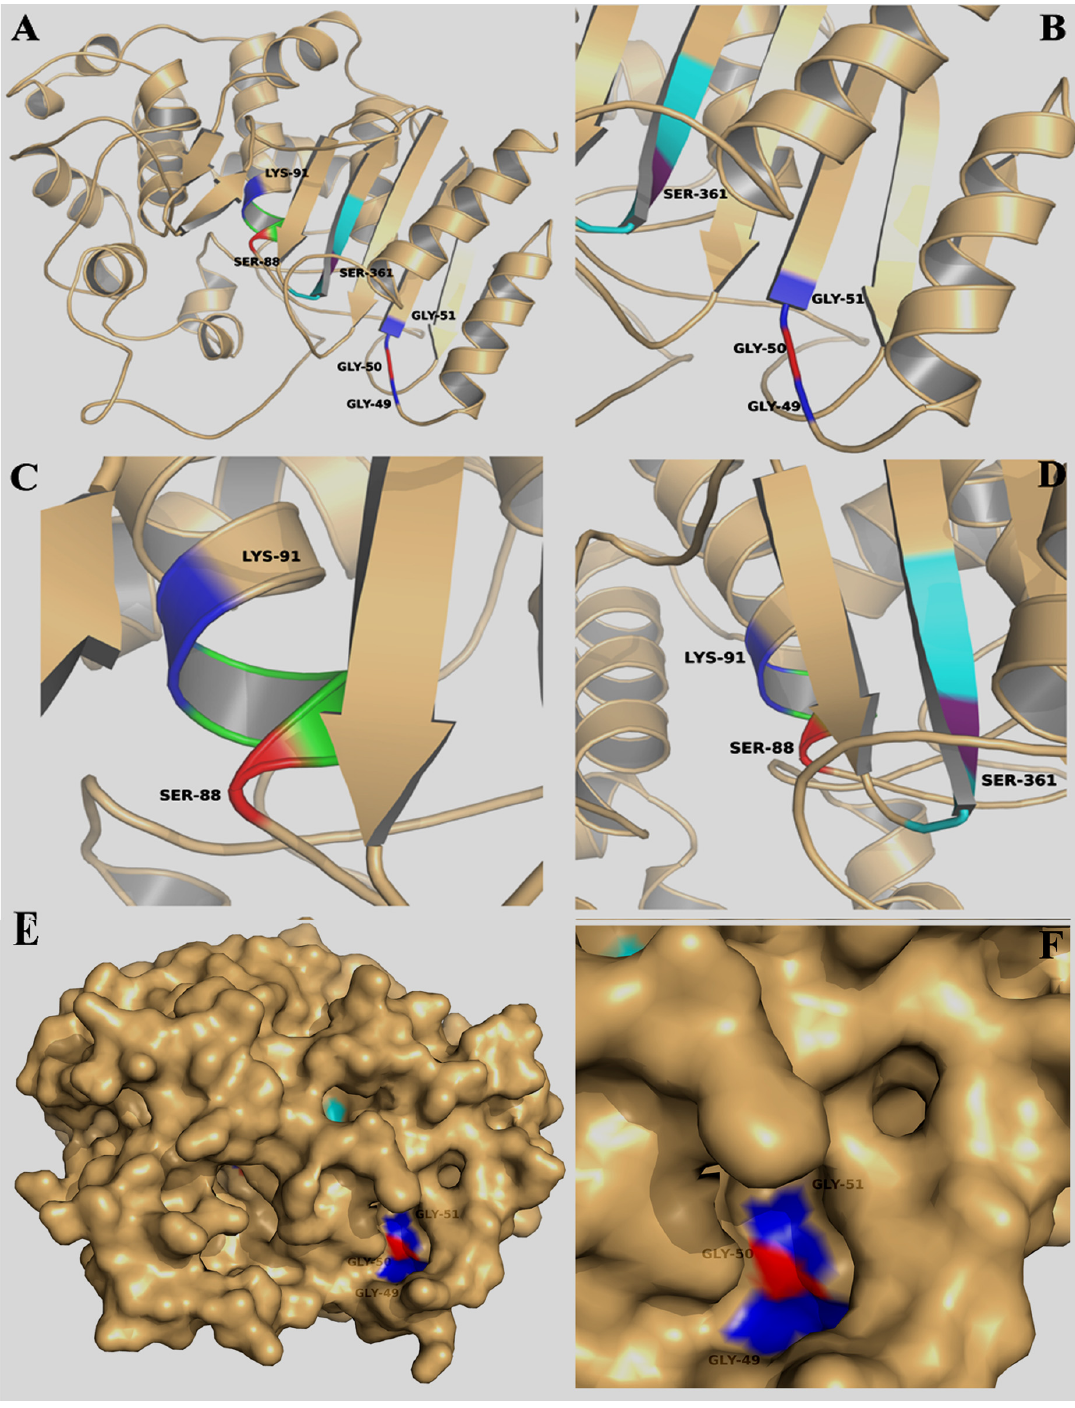
Fig 4. Homology model of LipL (template: EstA carboxylesterase, PDB code: 3ZYT). (A) Ribbon view of LipL model which consisted of several α helices and β sheets. The predicted active residues are shown in different colors. (B) Enlarged view of GGG motif (residues G49 and G51 are shown in blue; residue G50 is shown in red). (C) The close-up view of the S-x-x-K motif (residue S88 is shown in red; residue K91 is shown in blue). (D) Enlarged view of the G-x-S- x-G motif (residue S361 is shown in purple). (E) The partially transparent surface representation of LipL. The GGG motif is highlighted shown in blue and red colors. It is noteworthy that the GGG motif is formed a catalytic pocket surface structure. (F) The close-up view of the surface representation of the GGG motif.